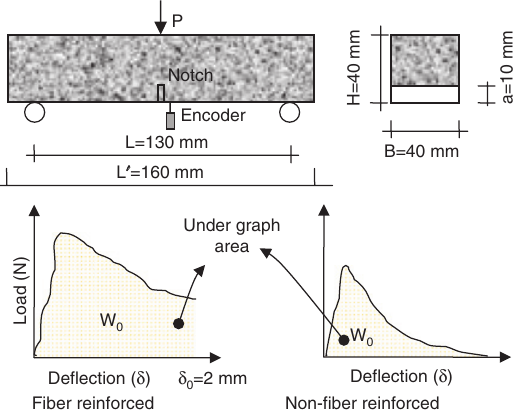
Figure 1 Schematic presentation of three-point bending test.